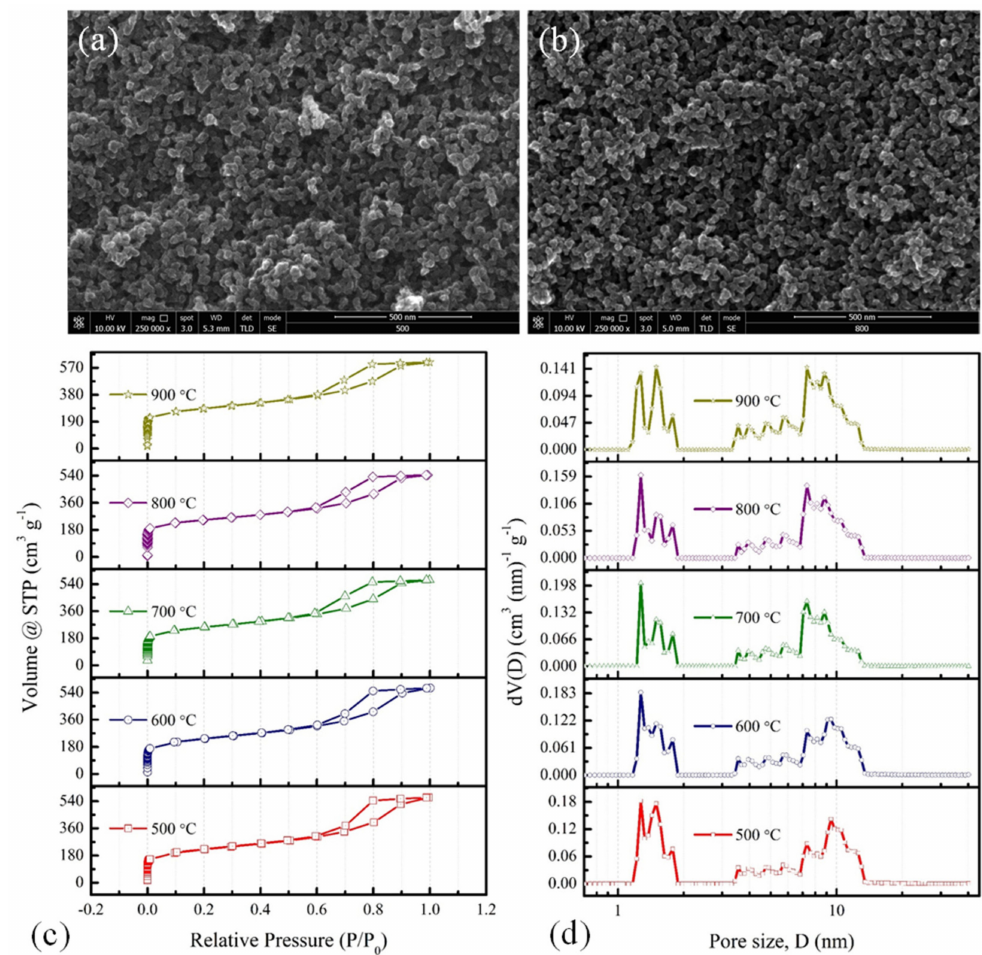
Figure 1. SEM images of CXs at ( a ) 500 ◦ C, and ( b ) 800 ◦ C, ( c ) nitrogen adsorption–desorption isotherms, and ( d ) pore size distributions for CXs obtained at different carbonisation